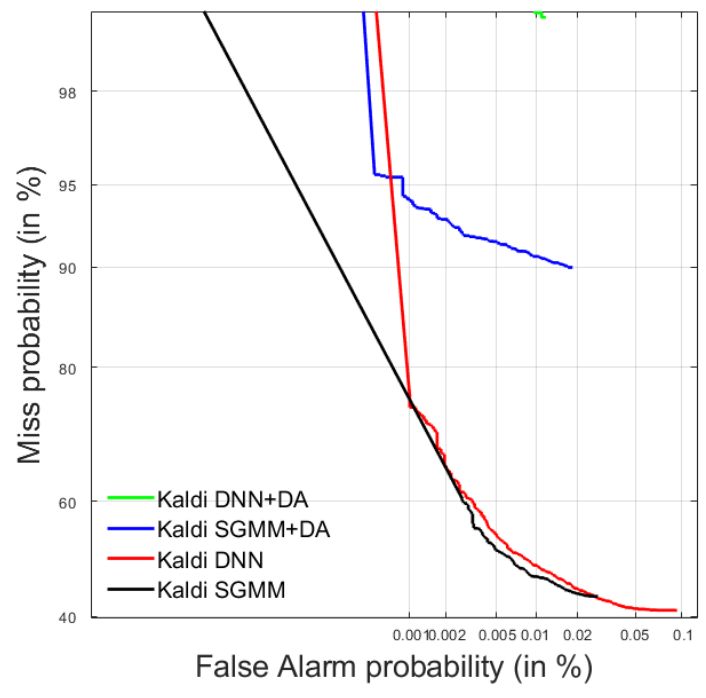
Figure 5. DET curves of the STD systems for MAVIR test